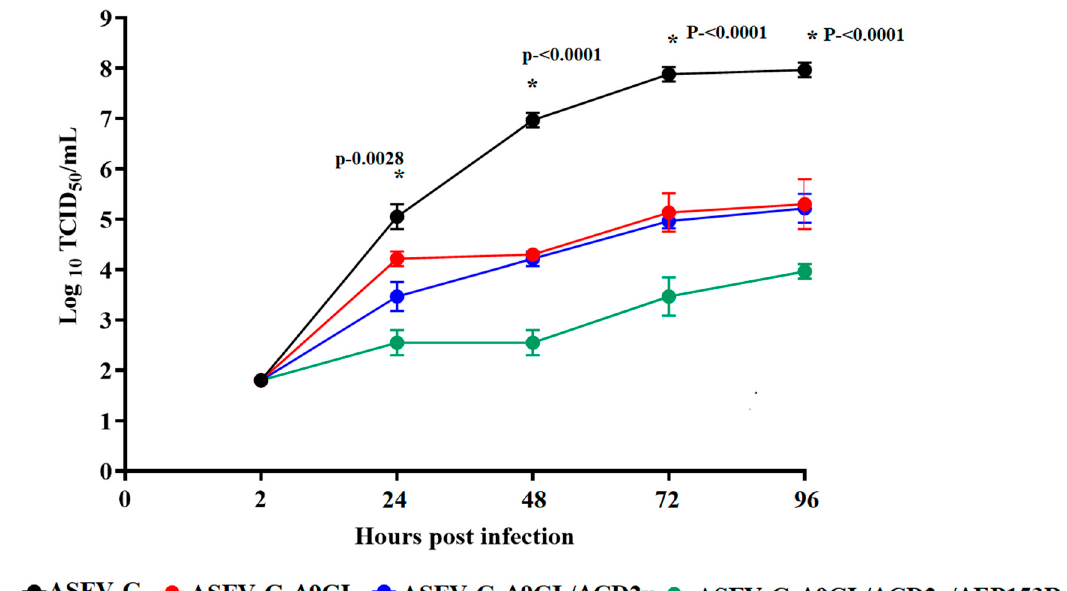
Figure 2. In vitro growth kinetics in primary swine macrophage cell cultures for ASFV-G- ∆ 9GL / ∆ CD2v, ASFV-G- ∆ 9GL / ∆ CD2v / ∆ EP153R, parental ASFV-G- ∆ 9GL or field isolate ASFV-G. Macrophage cultures were infected (MOI = 0.01) with either virus. Samples were taken from three independent experiments at the indicated time points and titrated. Data represent the means and standard deviations. Sensitivity using this methodology for detecting virus: > log 10 1.8 tissue culture infectious doses (TCID 50 ) / mL. Statistical significance (*) was determined using the Holm–Sidak method ( α = 0.05). Computations assume that all rows are samples from populations with the same scatter (SD). Analysis was conducted on Graphpad Prism software version 8.2.1.